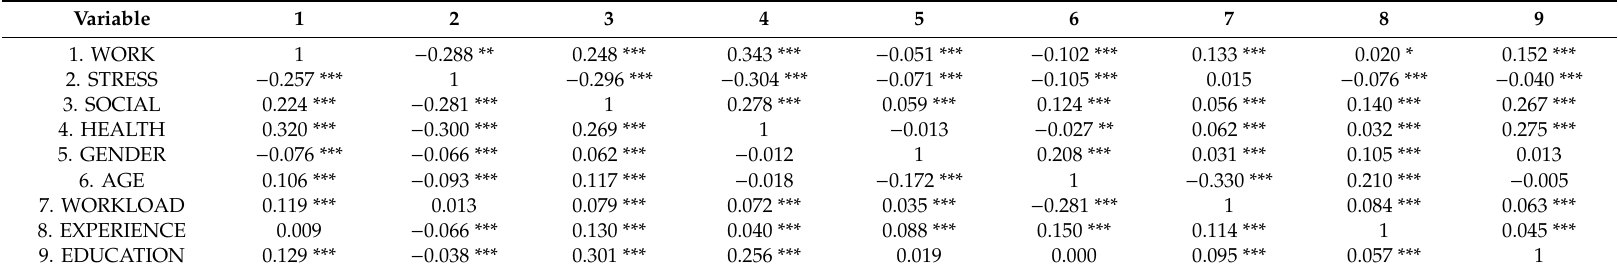
Table 3. Correlation coe ffi cients for